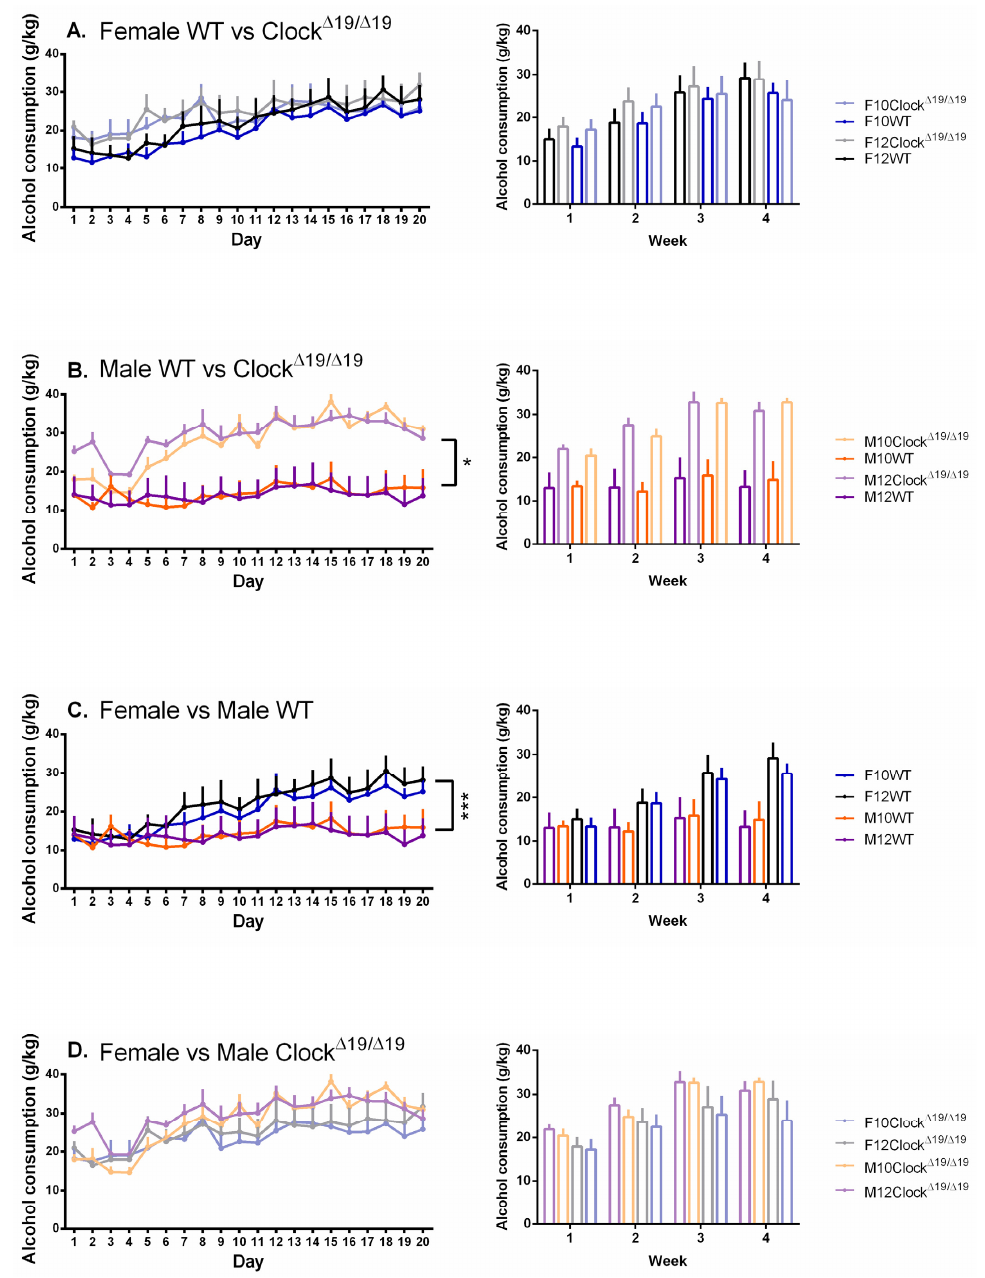
Figure 2. The amount of alcohol consumed by mice is influenced by sex, genotype, and number of drinking days, but not L:D cycles. ( A ). Female WT and Clock ∆ 19/ ∆ 19 mice, regardless of L:D cycles, showed no differences in the amount of alcohol consumed over time. ( B ). Over time, the amount of alcohol consumed by male Clock ∆ 19/ ∆ 19 mice increased such that they were consuming more than the male WT mice for most of the study period. ( C ). The amount of alcohol consumed by female mice diverged from that of male WT mice across the 20-day testing period. ( D ). Female and male Clock ∆ 19/ ∆ 19 mice demonstrated similar amounts of alcohol consumed across the 20-day testing period. F = females, M = males; 12 = 12:12 L:D cycle, 10 = 10:10 L:D cycle; WT = wild-type. Darker tones are WT mice and lighter tones are Clock ∆ 19/ ∆ 19 mice. Black = female 12:12 L:D group, blue = female 10:10 L:D group, purple = male 12:12 L:D group, orange = male 10:10 L:D group. * = p < 0.05, *** = p <